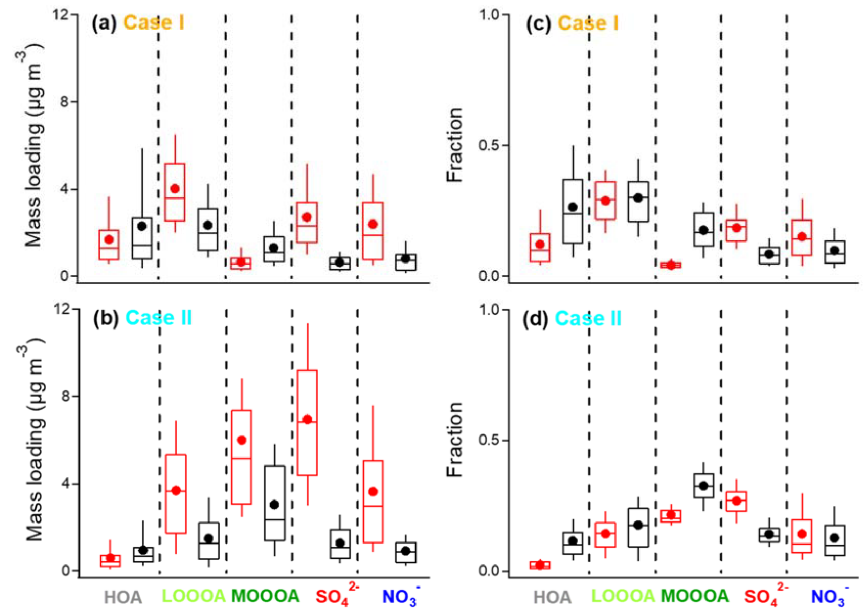
Figure 4. Box plots of mass loadings and fractions of five selected species (HOA, LO-OOA, MO-OOA, SO 2 − The bounds of boxes represent quartiles, the whiskers indicate the 90th and 10th percentiles, and the lines and dots inside the boxes are median and mean values. NR − PM 1 OA factors are in red, and the BC − PM 1 OA factors are in black.